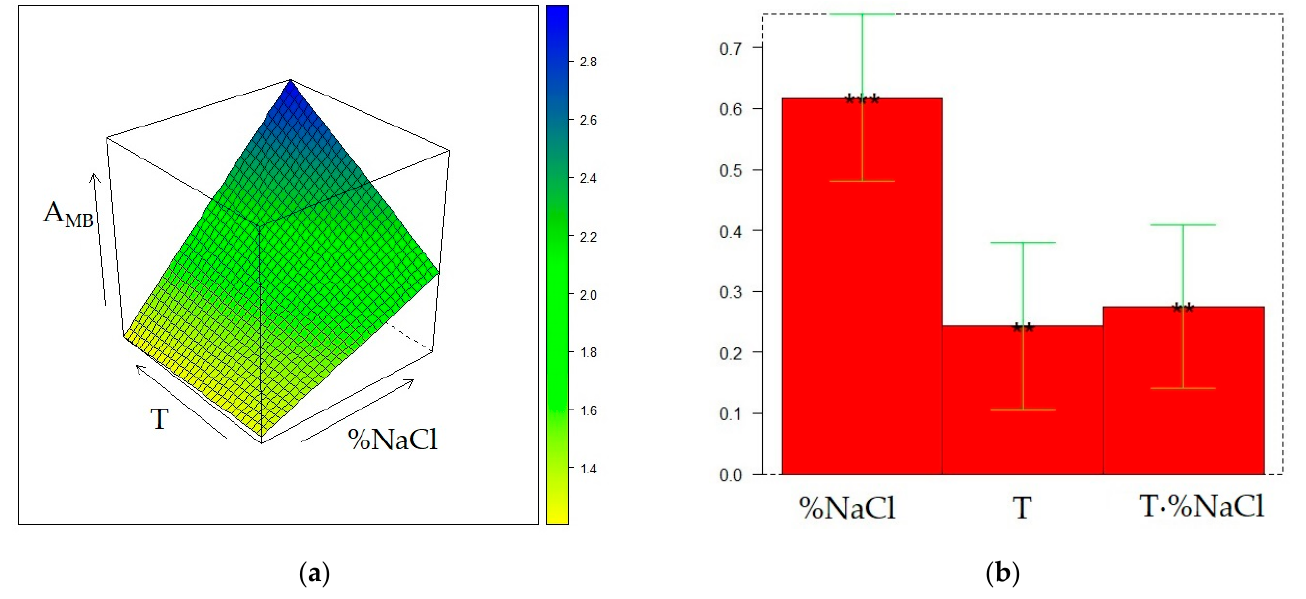
Figure 6. Optimization of HS-SPME collection of wine volatile profiles with the DVB/CAR/PDMS fiber: ( a ) response surface for the peak area of 3-methyl-1-butanol (A MB ); ( b ) coefficients of the surface model: p < 0.01 (**), p < 0.001(***).